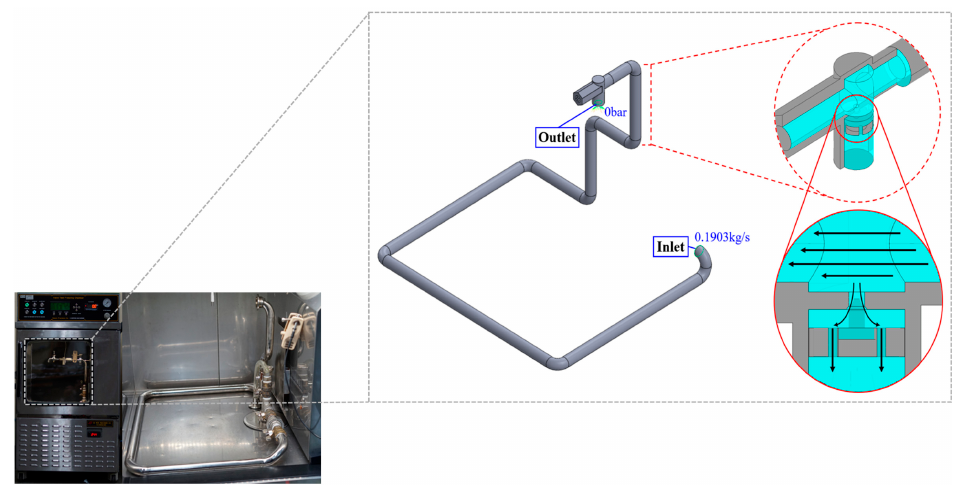
Figure 10. Schematics of the model and boundary conditions for fluid analysis.